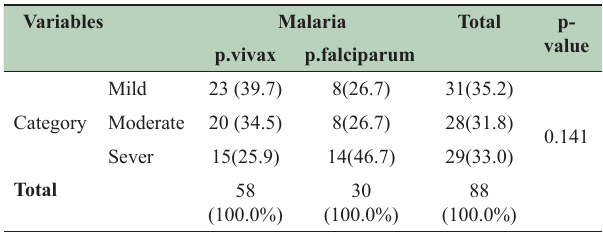
Table-II: Association of thrombocytopenia with malaria